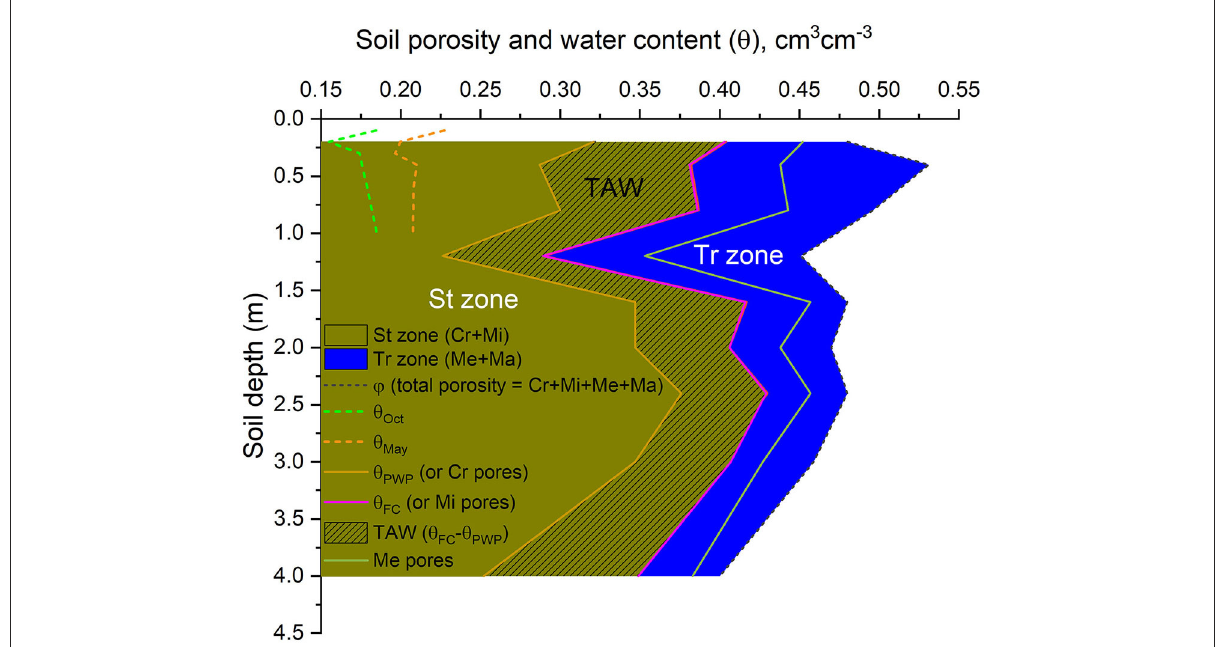
FIGURE2 Soil properties expressed in terms of soil porosity, water content ( θ ), and plant water availability) for the upper 4 m of the soil profile. The yellow area is the storage (St) zone, which comprises the Cr (orange solid line) and Mi (pink solid line) pore sizes, and the blue area is the transmission (Tr) zone, which comprises the Me (in green) and Ma pores. Total porosity ( ϕ ; black dotted line) comprises the sum of Cr, Mi, Me, and Ma pores. In terms of water availability conditions, θ FC is the field capacity, and coincides with Mi pores (pink solid line), θ PWP is the plant wilting point and coincides with the Cr pores (orange solid line), and TAW is the total available water to plants (i.e., θ FC – θ PWP ; yellow dashed area). It is also shown soil moisture conditions (cm 3 cm − 3 ) at the upper meter of the soil profile, in May 2016 (dashed line in green) and in October 2016 (dashed line in orange) based on EC flux tower data from LBA. Data used are presented in Table